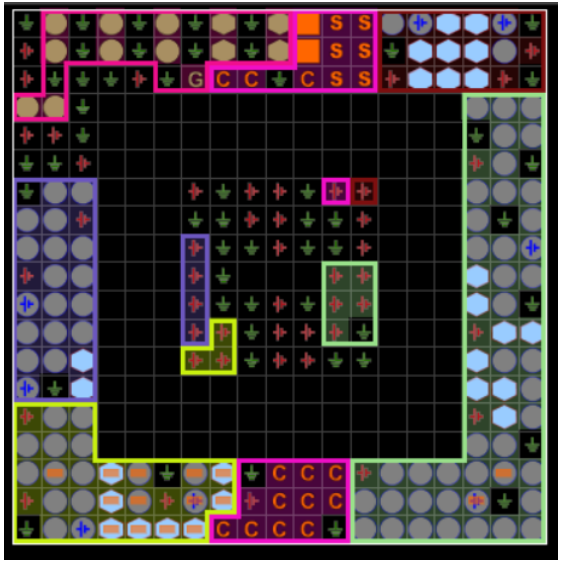
Figure 4. I/O pin mapping representation of the trojan-free design.